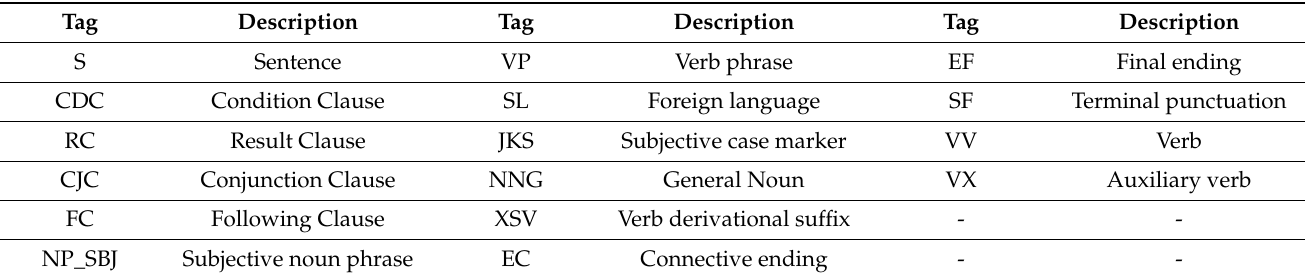
Table 1. Parts of POS tags in the Korean language.